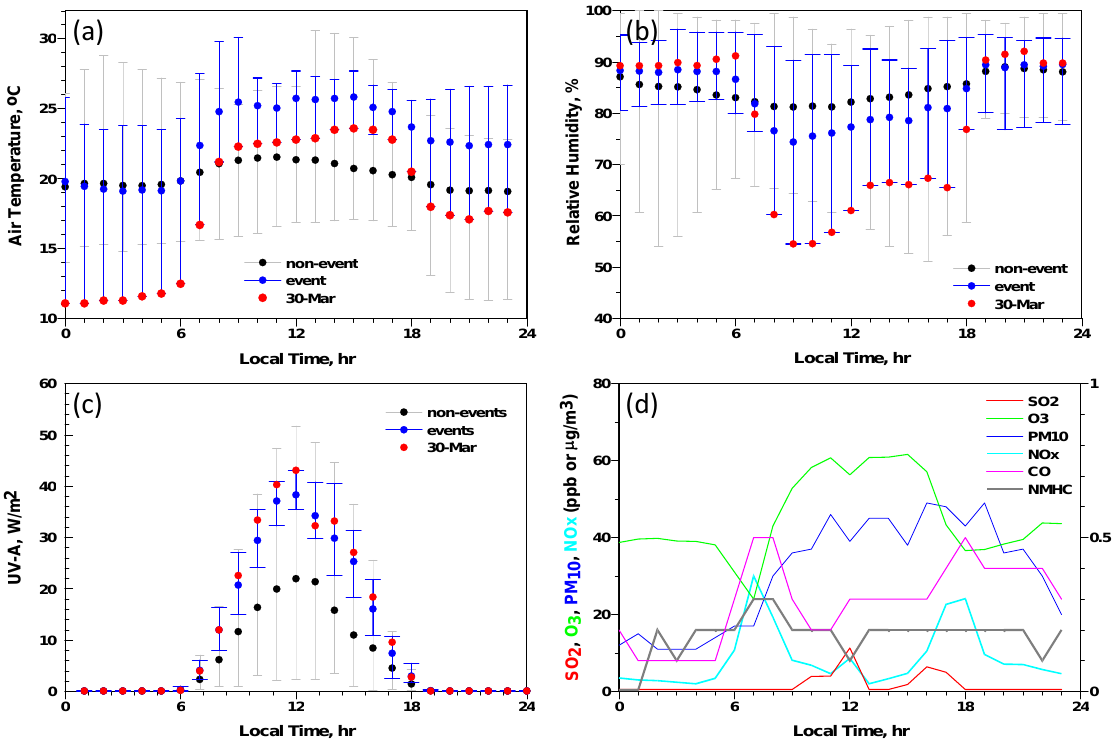
Fig. 2. Diurnal variations of (a) air temperature, (b) relative humidity, (c) UV-A radiation, and (d) concentration of trace chemicals in air. The first 3 panels show averages and spreads for all non-nucleation (black dots) and nucleation (blue dots) events, as well as values for the 30 March event (red dots). Panel (d) shows only the 30 March